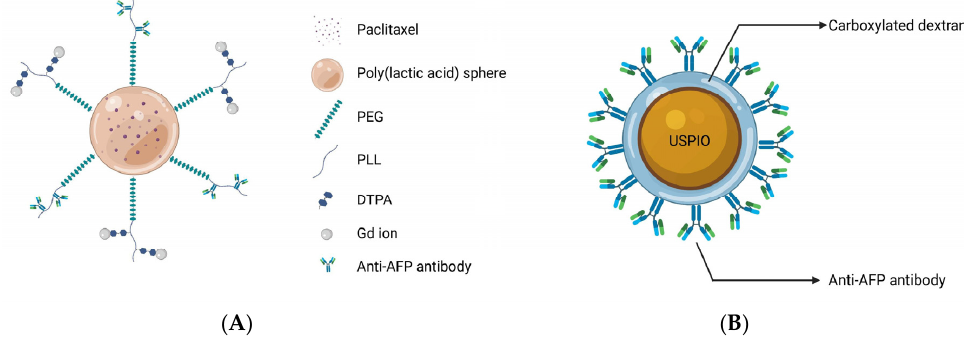
Figure 3 Figure 3. ( A ) The Gd ions used for MR imaging and the antibodies targeting AFP were connected to the outer surface of spherical micelles, and the paclitaxel were encapsulated in the core of micelles